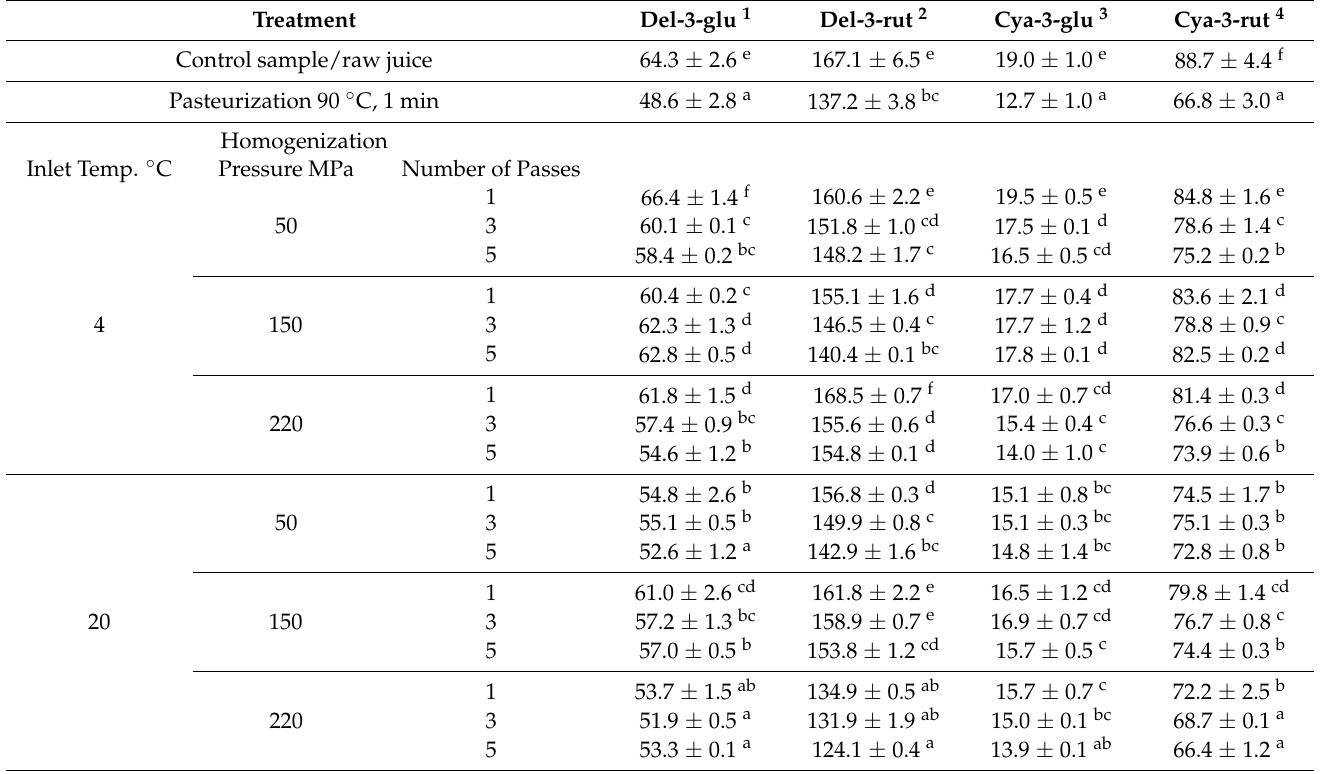
Table 2. Anthocyanin monomers content (mg/100 mL) in cloudy blackcurrant juice treated with high-pressure homogeniza- tion or